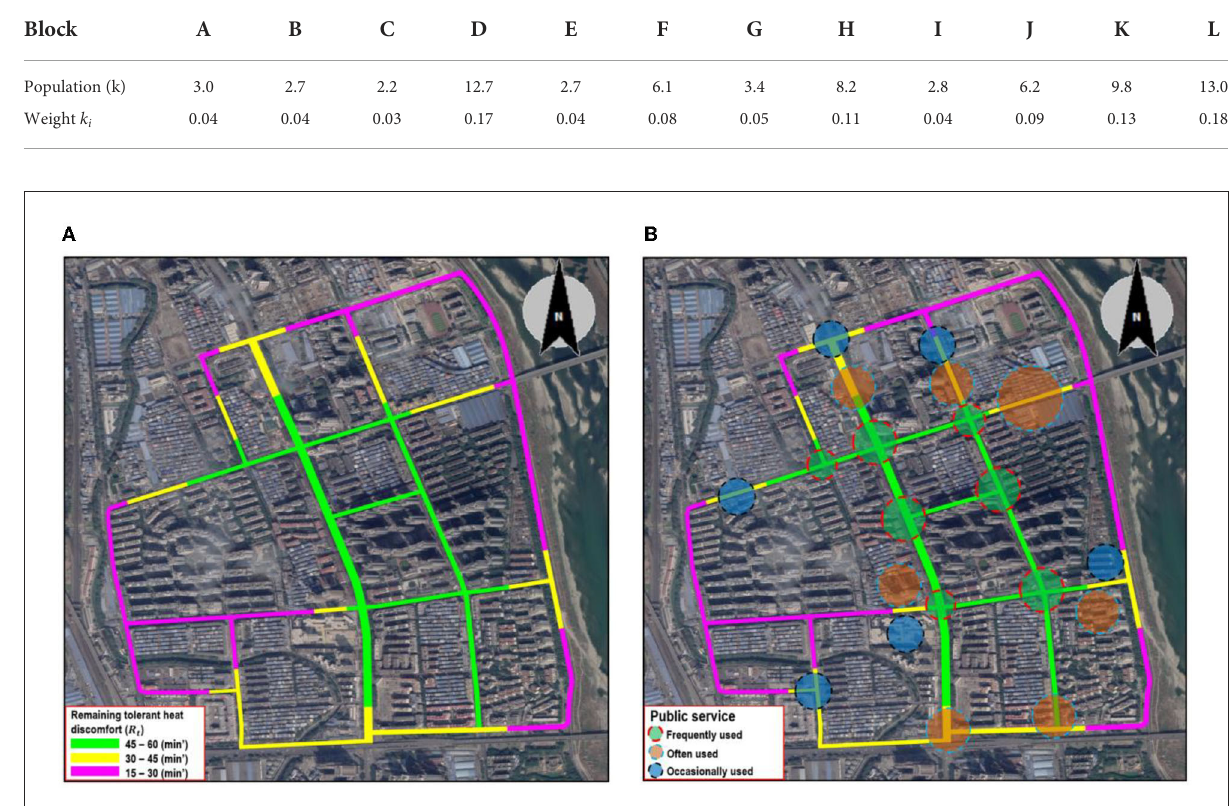
FIGURE10 Overall street walkability of the FMC (A) and associated public service planning (B)